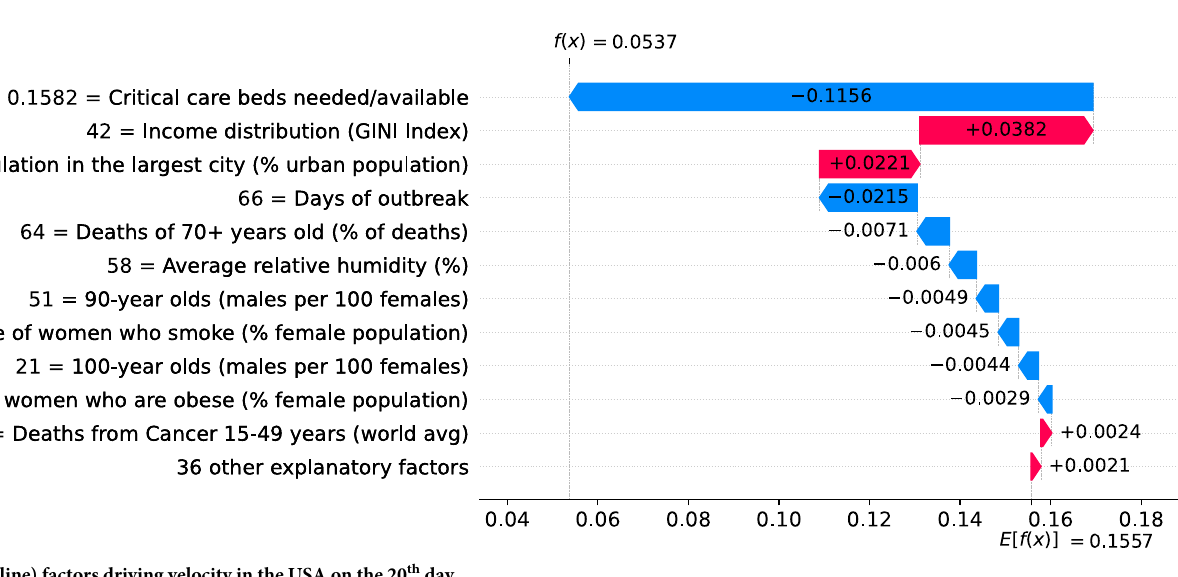
Fig 37. (Color online) factors driving velocity in the USA on the 20 th